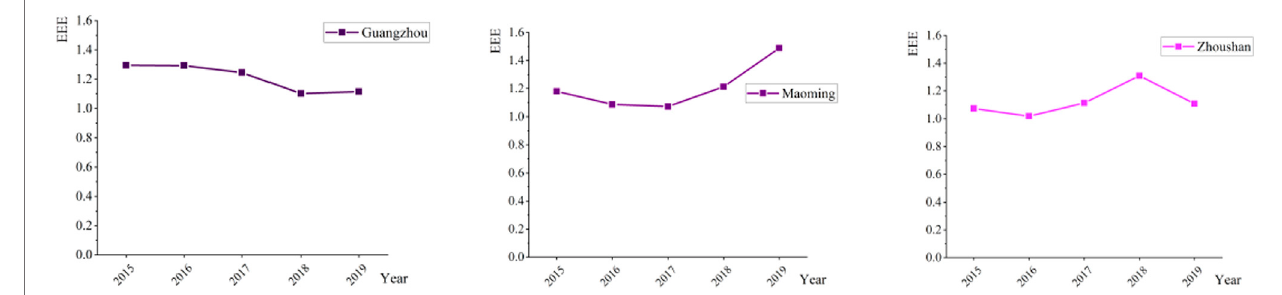
FIGURE 5 | The top three cities in the EEEs from 2015 to